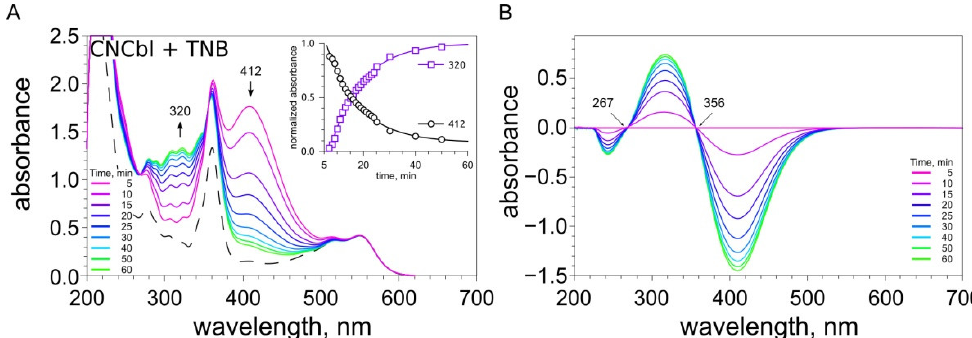
Figure 5. UV-Vis spectra recorded in the reactions between CNCbl and TNB. ( A ) Absorption spectra. Insert: kinetic traces recorded in the corresponding reaction at selected wavelengths. ( B ) Difference spectra.